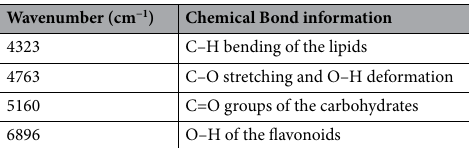
Table 1. Chemical bond information corresponding to spectral characteristic peaks of raisin pericarps 26,29–31 .